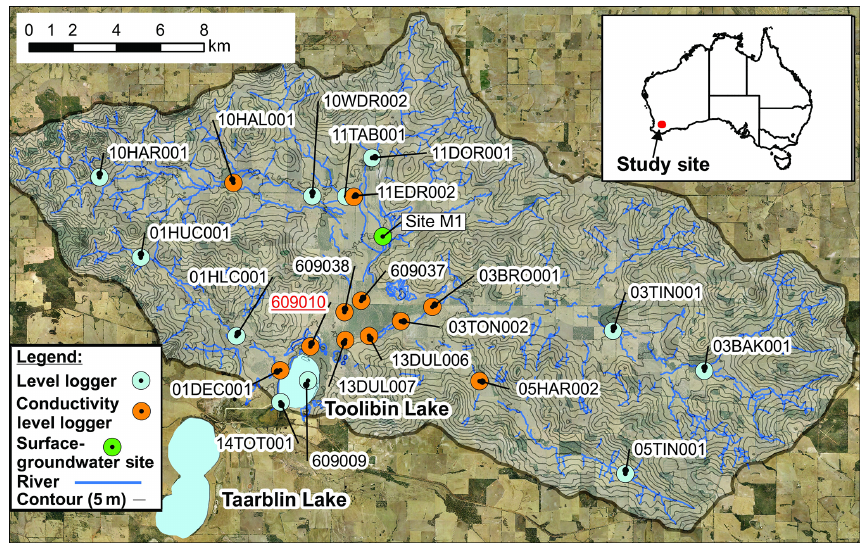
Figure 1. Toolibin Lake catchment showing the monitoring sites coded according to whether conductivity and/or level data are recorded. Drainage lines highlight the often discontinuous and meandering surface hydrologic pathways with poor downstream connectivity in the valley floor. Map created with field data and open-access data through the Western Australia Government Shared Location Information Platform and Creative Commons data from Geoscience